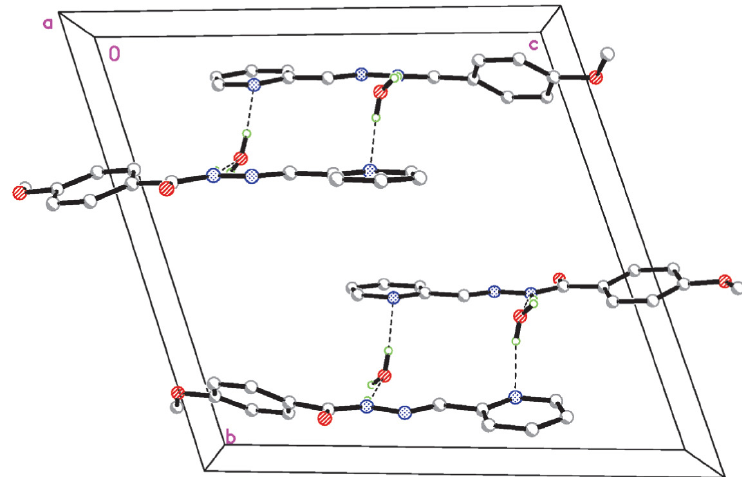
Figure 2. Molecular packing structure of HL, viewed along the a axis. Hydrogen bonds are shown as dashed lines.